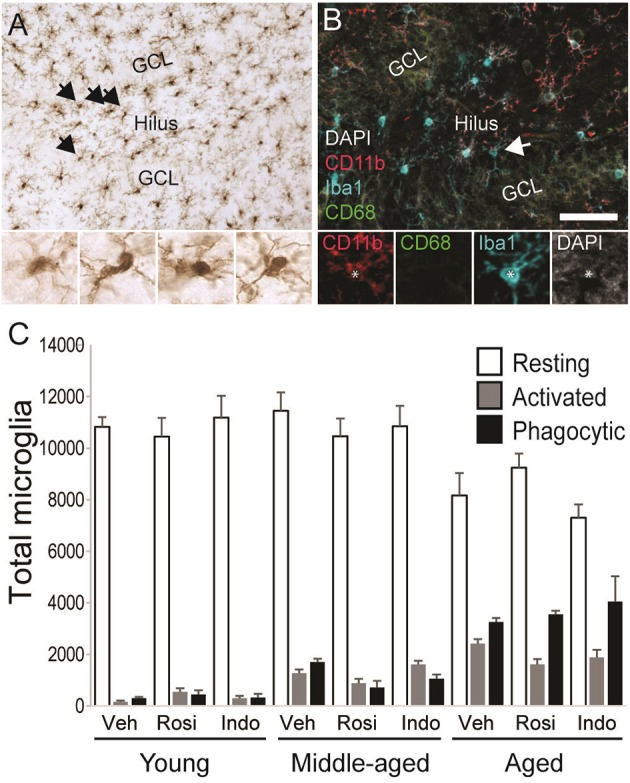
Microglial activation increased with age. (A) A representative transmitted light photomicrograph of the dentate gyrus showing Iba1+ microglia (in brown). The arrows indicate Iba1+ cells that are shown in the insets under 40x. (B) A confocal image of the dentate gyrus taken under a 20x objective (with 1.5x digital zoom) showing Iba1+ cells (in blue), the marker of activation CD11b (in red), the phagocyte marker CD68 (in green) and the nuclear stain DAPI (in gray). The total number of resting Iba1+ microglia, activated Iba1+/CD11b+ microglia and phagocytic Iba1+/CD11b+/CD68+ microglia were calculated. The arrow shows each marker independently in a phagocytic microglia. The scale bar = 50 μm. (C) shows the total number of resting (white bars), activated (gray bars), and phagocytic (black bars) microglia in vehicle-, rosiglitazone, and indomethacin-treated young, middle-aged, and aged rats. Generally, microglia numbers were higher in middle-aged and aged vs. young rats (both p < 0.01) and more resting (p < 0.001 vs. activated and phagocytic) followed by phagocytic (p < 0.05 vs. activated) microglia were detected. Resting microglia numbers were higher in young vs. aged rats (p < 0.001), activated microglia numbers were higher in aged vs. young rats (p < 0.001) and phagocytic microglia numbers higher in aged (p < 0.001 vs. middle-aged and young rats) followed by middle-aged (p < 0.05 vs. young rats) rats. In young and middle-aged rats, resting microglia outnumbered activated and phagocytic microglia (all p < 0.001). In aged rats, resting microglia outnumbered activated and phagocytic microglia (both p < 0.001) and phagocytic microglia outnumbered activated microglia (p < 0.001).